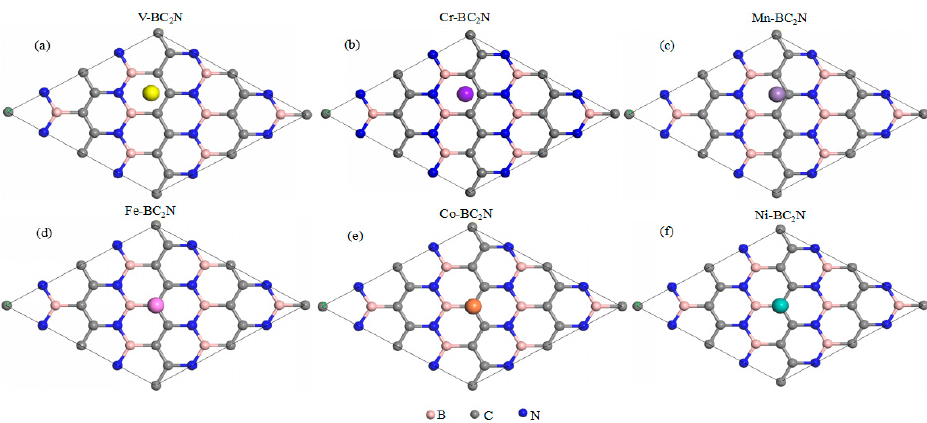
Figure 4. Top view of the most stable structures for transition metal atoms adsorbed monolayer BC 2 N. Table 1. The adsorption position, the adsorption energy ( Ea ), the perpendicular distance between TM atoms and monolayer BC 2 N ( d TM-h ).